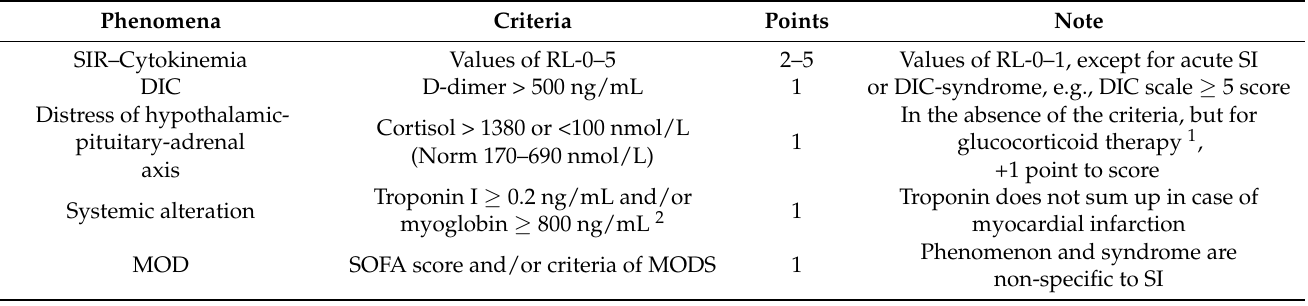
Table 5. Integral SI